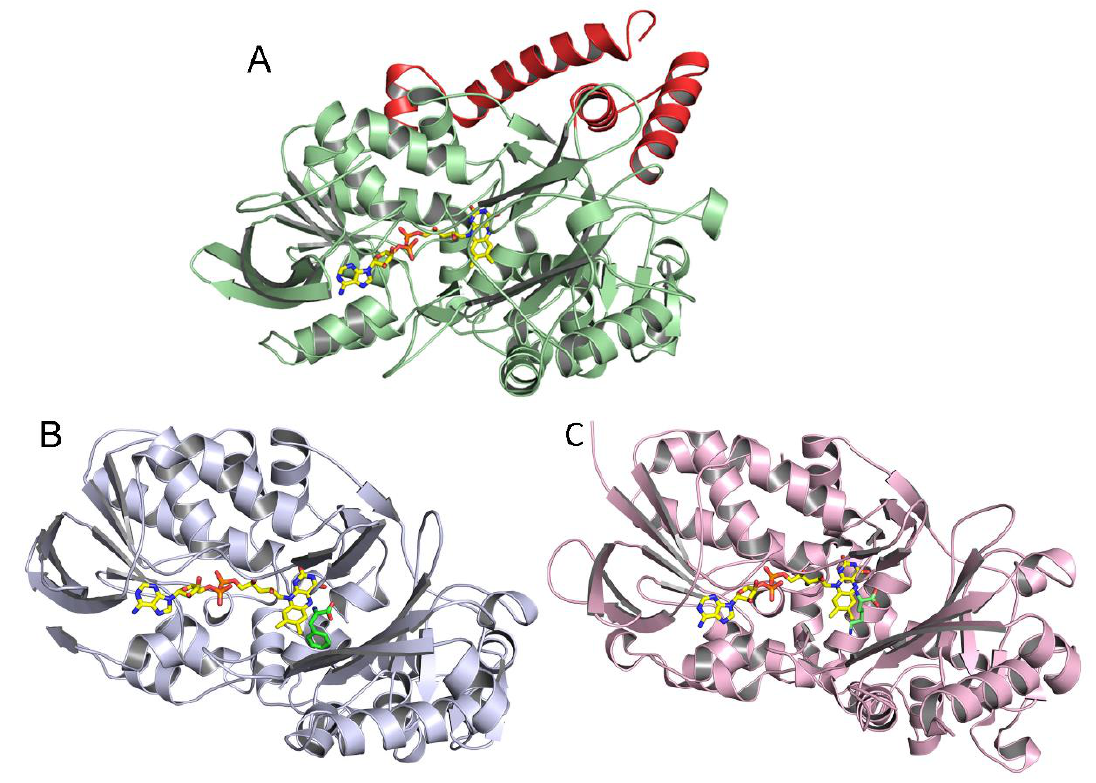
Figure 6. Monomeric structures of LAAOs. ( A ) P. luteoviolacea CPMOR-1 LAAO. ( B ) SvLAAO from C. rhodostoma with Phe substrate bound (PDB 2IID) [28]. ( C ) TvLAAO (PBD 7C3H) [29] with Lys substrate bound. FAD is shown with the carbons of the isoalloxazine and adenine rings yellow, nitrogens blue, oxygens red, and phosphorous orange. The carbons of the Phe and Lys substrates are colored green. The additional helices present in P. luteoviolacea CPMOR-1 LAAO ( A ) that are not in the other LAAOs are colored red.